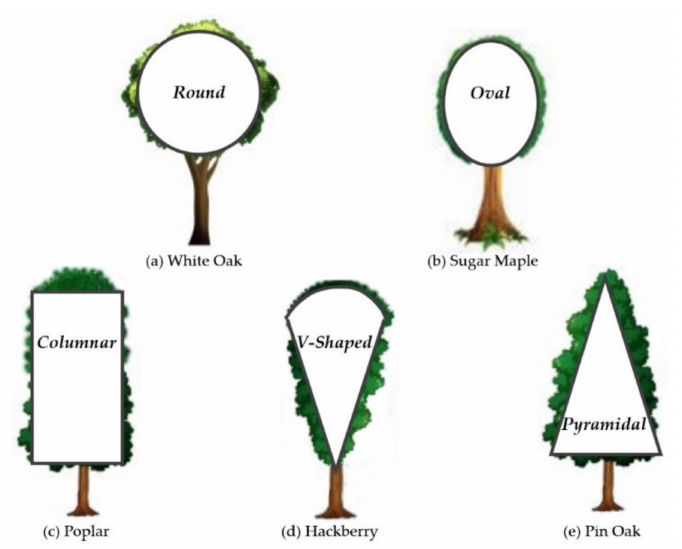
Figure 1. Crown shapes in nature [22]. Vegetation crown shapes are written in bold; the correspond- ing typical vegetation types are written in normal font and are: ( a – e